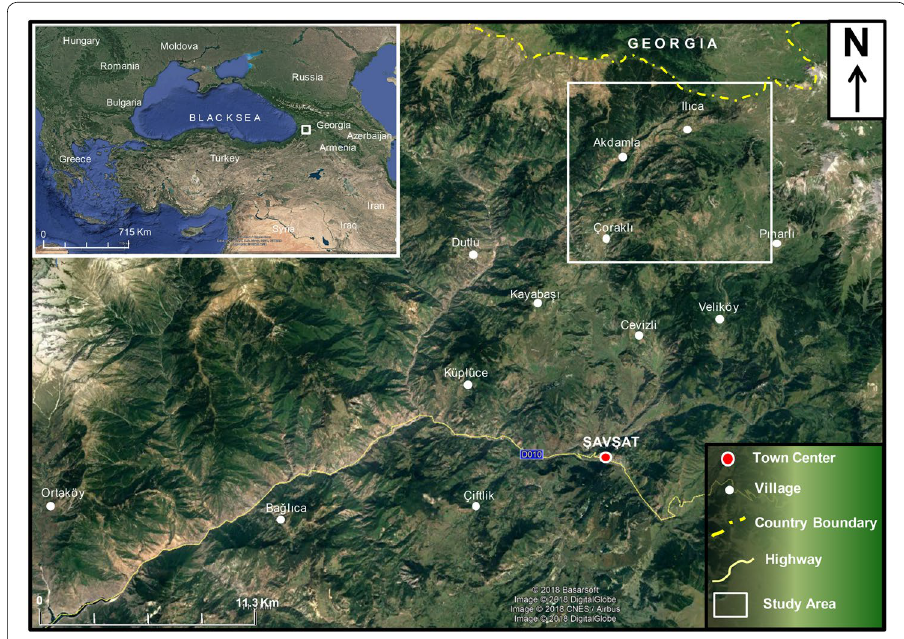
Fig. 1 Location map of the Şavşat (Artvin/Turkey) Geothermal